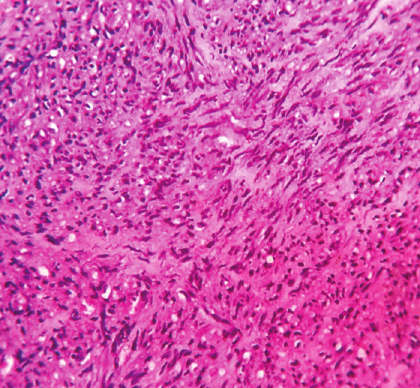
Figure 3: Intertwining bundles of spindle cells with abundant extracellular collagenous matrix (H&E stain, original magnification × 40).